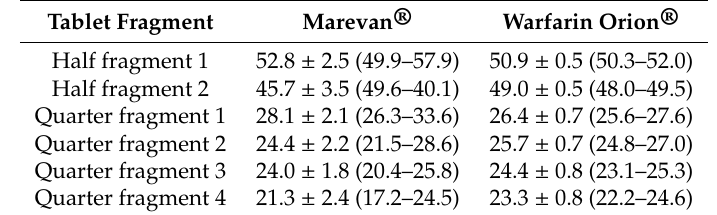
Table 2. Splitting accuracy of the two warfarin tablets investigated. Per cent of full tablet mass is given for half and quarter fragments, from largest fragment (Fragment 1) to smallest fragment. (Mean ± sd (low to high); n = 10)